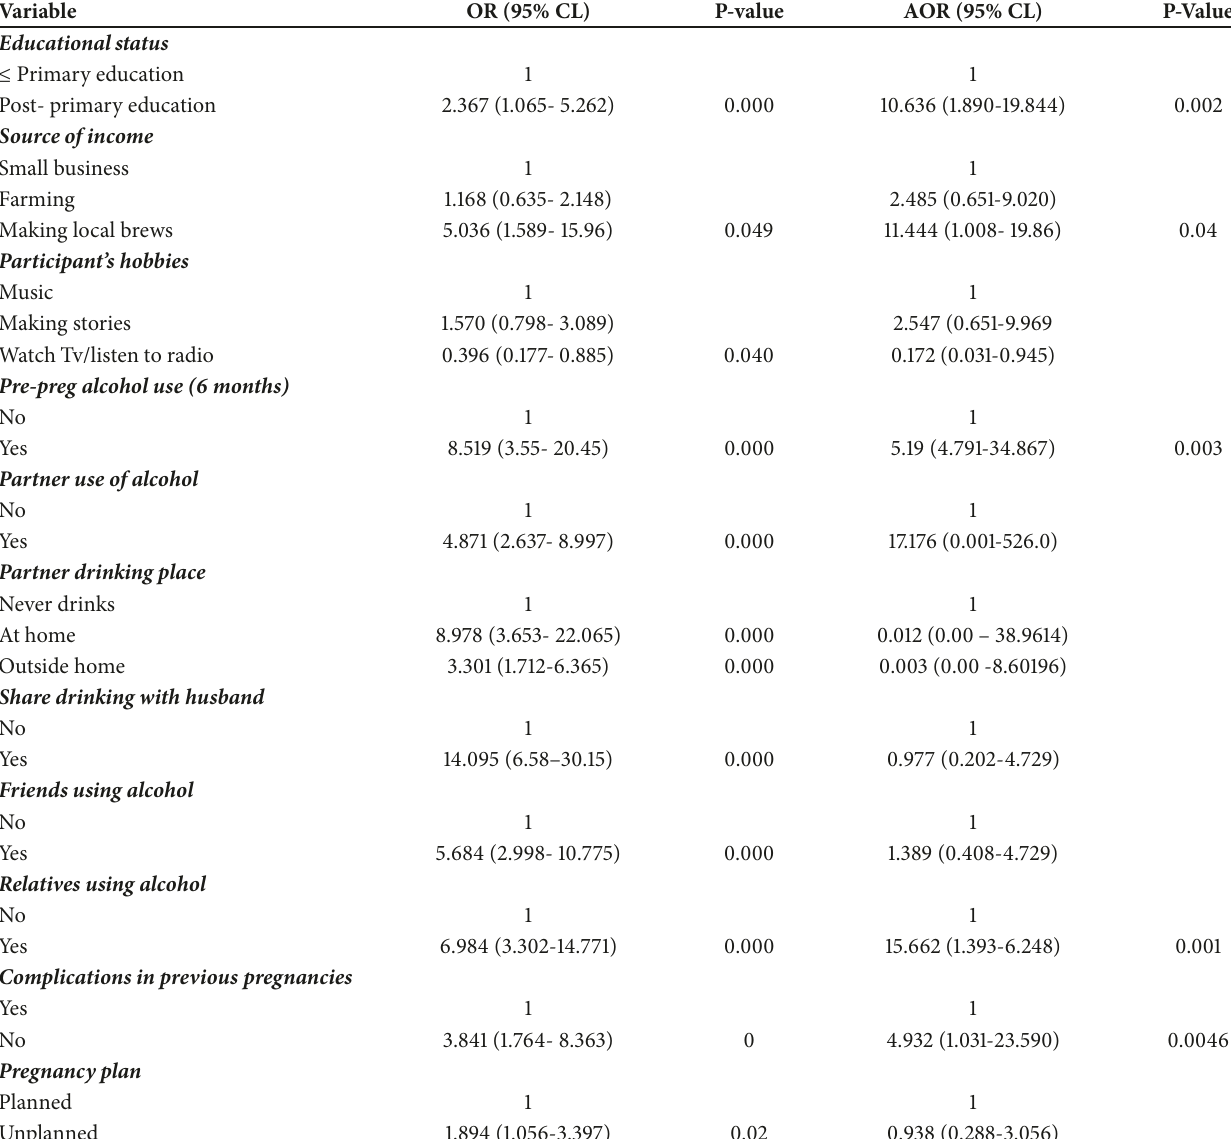
Table 4: Factors associated with alcohol use among pregnant women attending Reproductive and Child Health (RCH) clinic in Dodoma region